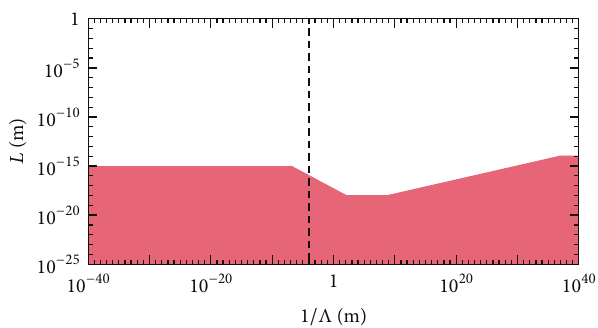
Figure 2: Summary of constraints on nonlocal space-time defects, from [4]. The red shaded region is excluded. The dashed (black) line indicates the value of the cosmological